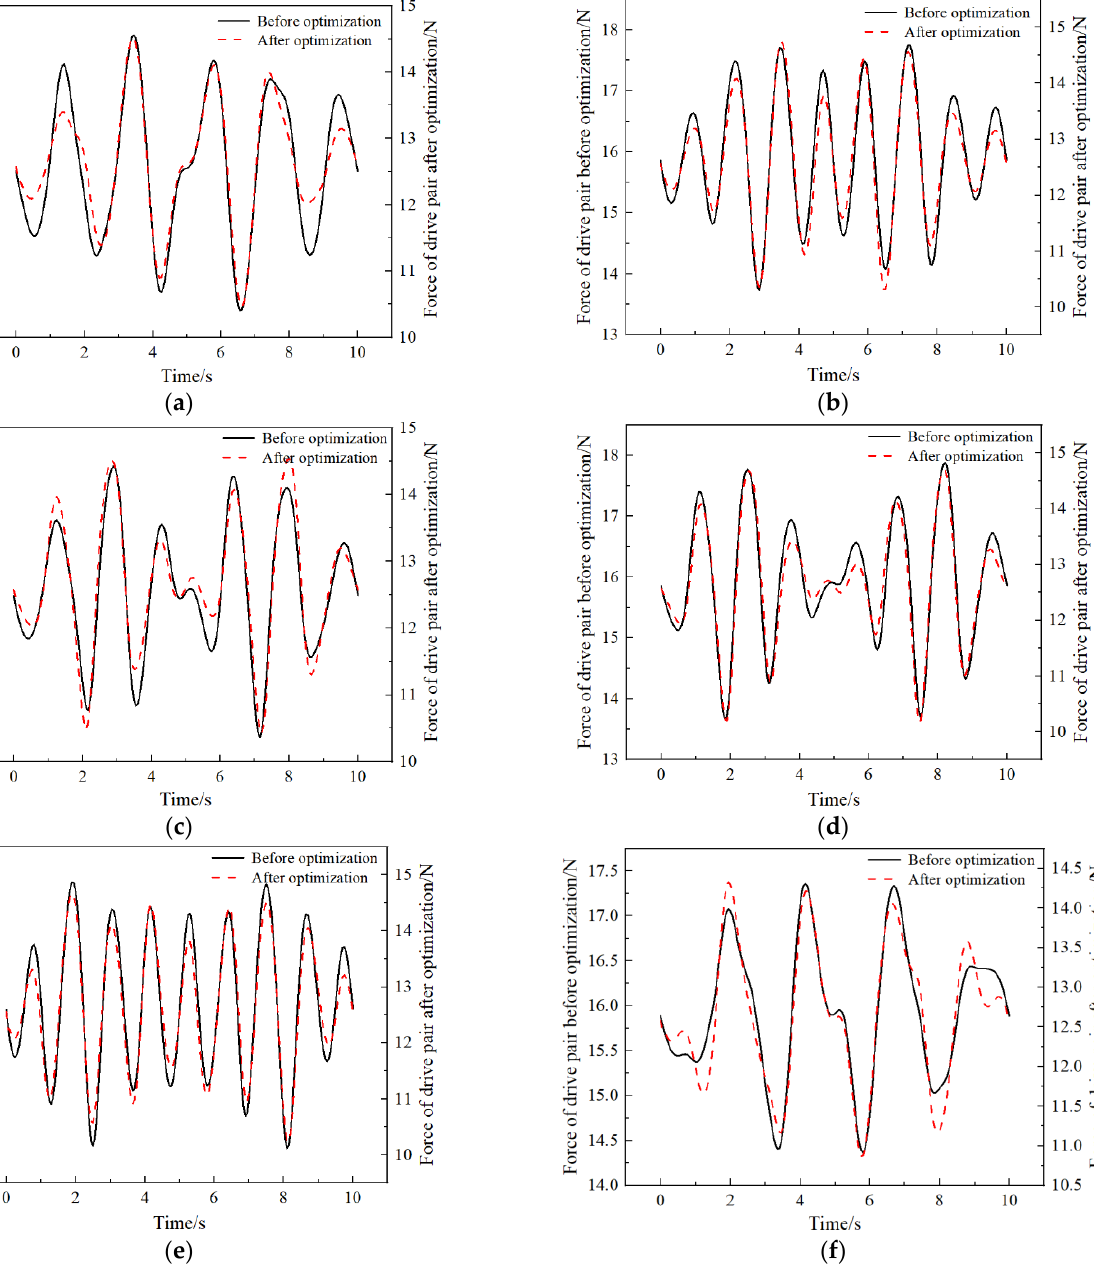
Figure 12. Force on the drive pair of the six drive branch chains before and after optimization: ( a ) Drive branch chain 1; ( b ) Drive branch chain 2; ( c ) Drive branch chain 3; ( d ) Drive branch chain 4; ( e ) Drive branch chain 5; ( f ) Drive branch chain 6.